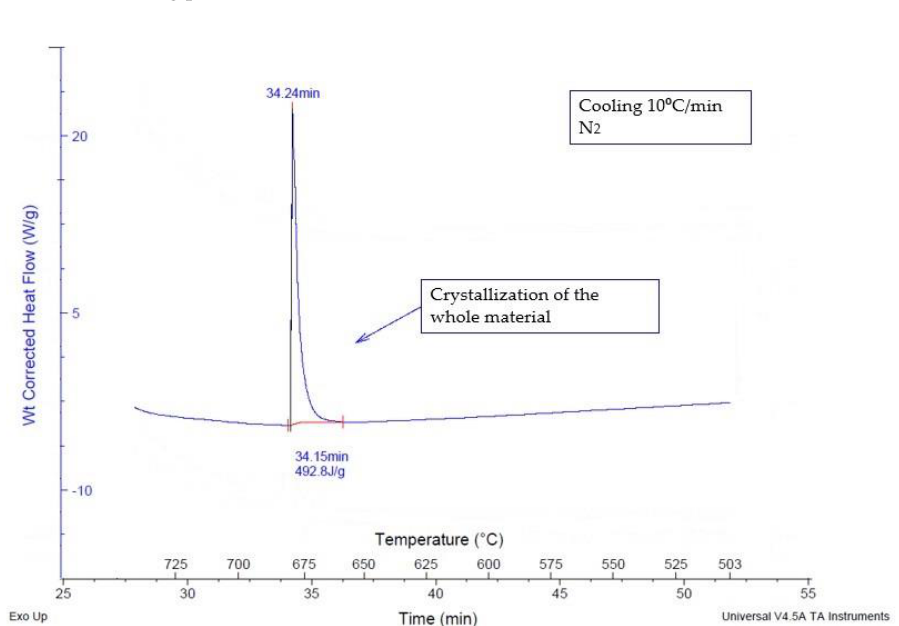
Figure 6. Cooling process in the DSC/TGA.